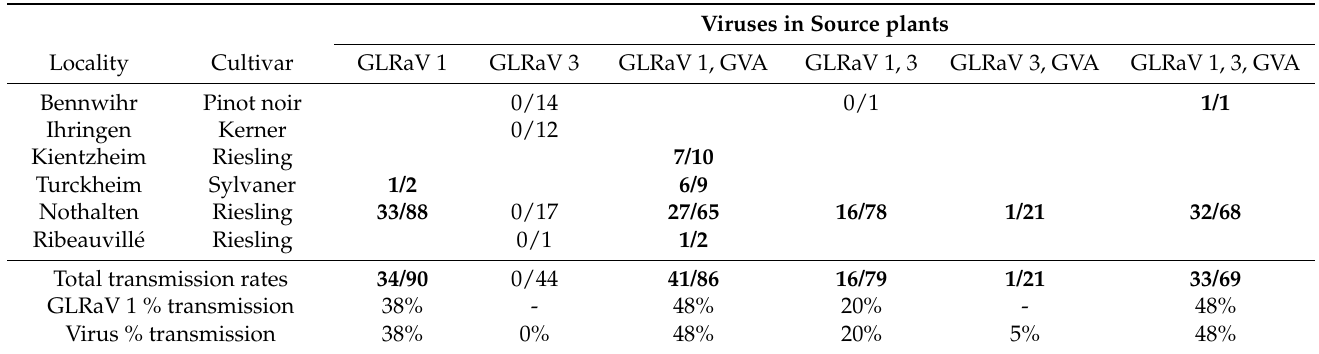
Table 5. Virus transmission rates by vineyard-collected L1 and L2 of Parthenolecanium corni according to locality and to virus associations in plant sources, after transmission experiments. Number of positive vines/number of inoculated vines. Transmission events are highlighted in bold.